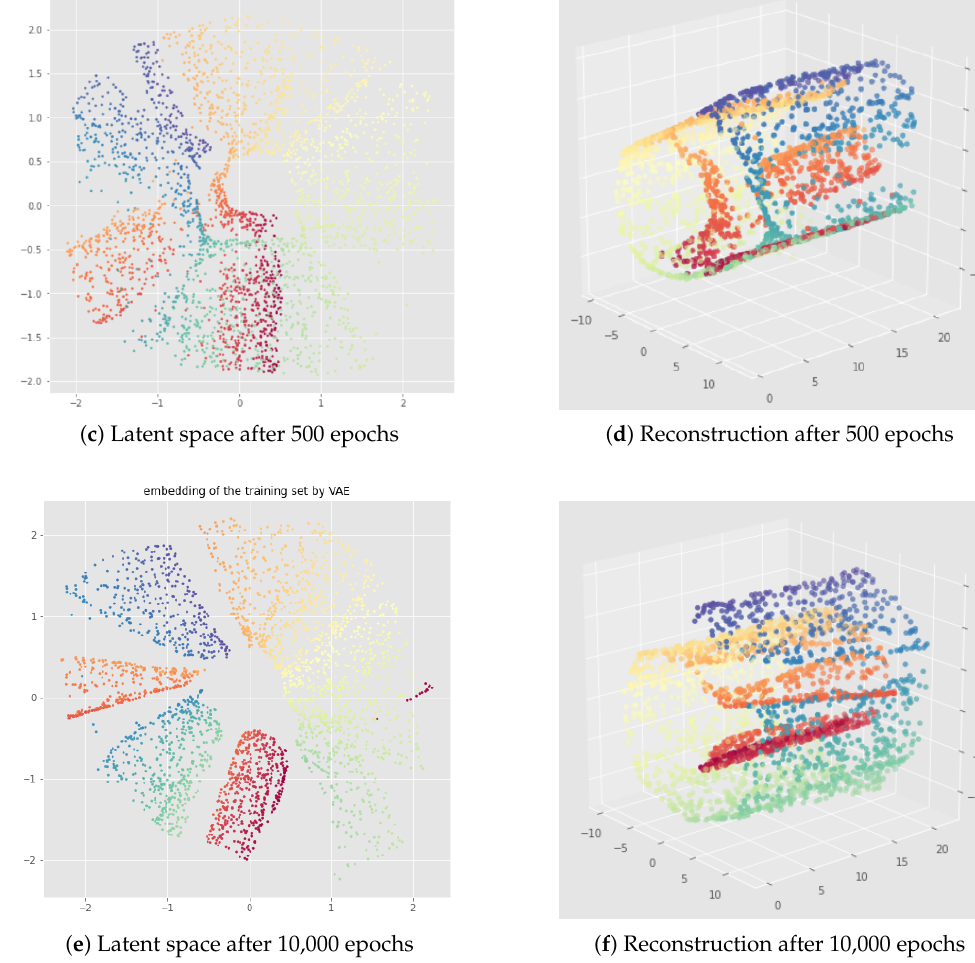
Figure 13. Latent representation (left column) and corresponding reconstruction (right column) of the Standard VAE applied to the swissroll - pytorchseed = 2, trained for 100; 500; and 10,000 epochs. After 100 epochs we can see an overlapping between the beginning and the end of the swissroll in the latent representation ( a ) which has β 1 = 1 instead of 0, and the reconstruction is bad ( b ). Then, the more the model is trained, the better is the reconstruction as we can see after 10,000 epochs for example ( f ), but the latent representation ( e ) is separated in many connected components whereas the original swissroll has β 0 =